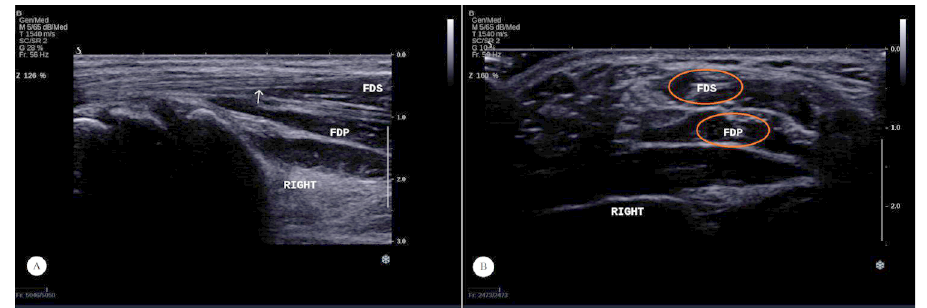
Fig 4. The positioning of the MTJ for FDS. (A) Longitudinal section of FDS tendon. (B) Cross sectional section of the MTJ for FDS.